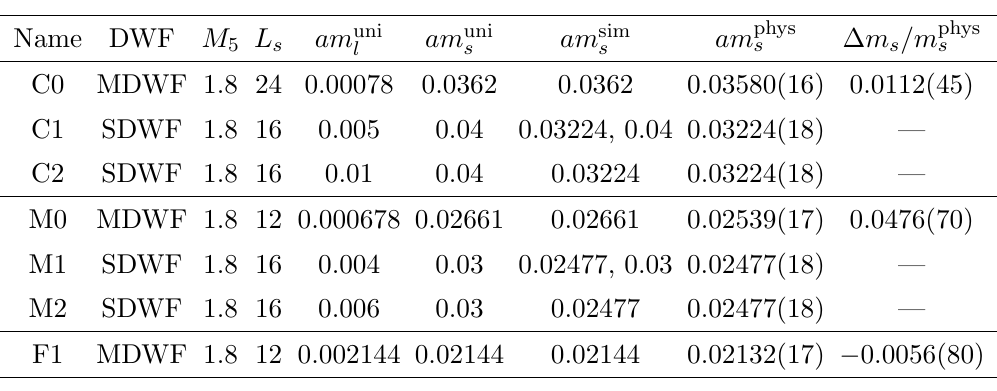
Table 2 . Domain wall parameters for the light and strange quarks. All quoted values for am l and am s are bare quark masses in lattice units. The column DWF corresponds to the chosen domain wall fermion formulation where ‘MDWF’ corresponds to M(cid:127)obius domain wall fermions, ‘SDWF’ to Shamir domain wall fermions. All light quarks are simulated at their unitary value am uni . Valence l strange quarks were simulated at am sim . Note that the value of the physical strange-quark s